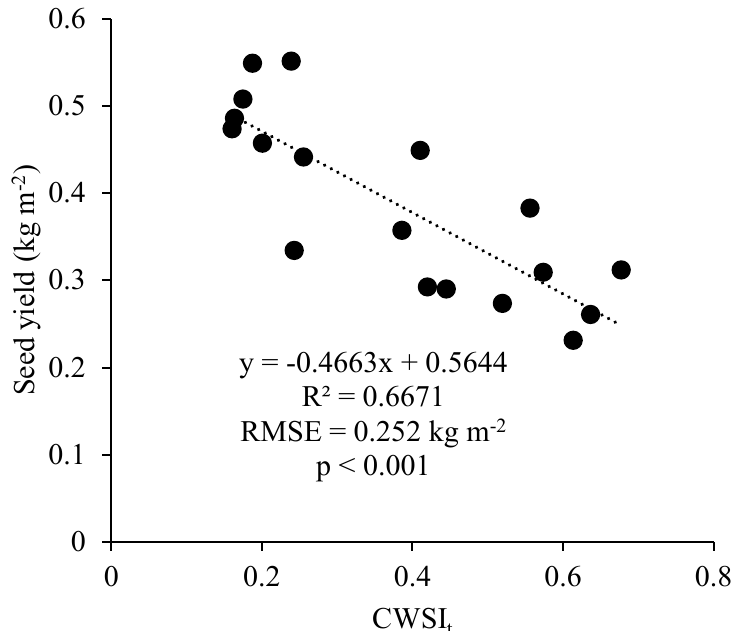
Figure 6. Relationship between theoretical crop water stress index, CWSIt and soybean seed yield of two varieties, Sinara (Sin) and Sigalia (Sig) grown under three watering levels (unlimited, water withdrawn and rainfed) during the seasons between 2017–2019. A single linear function was used to describe the relationship.